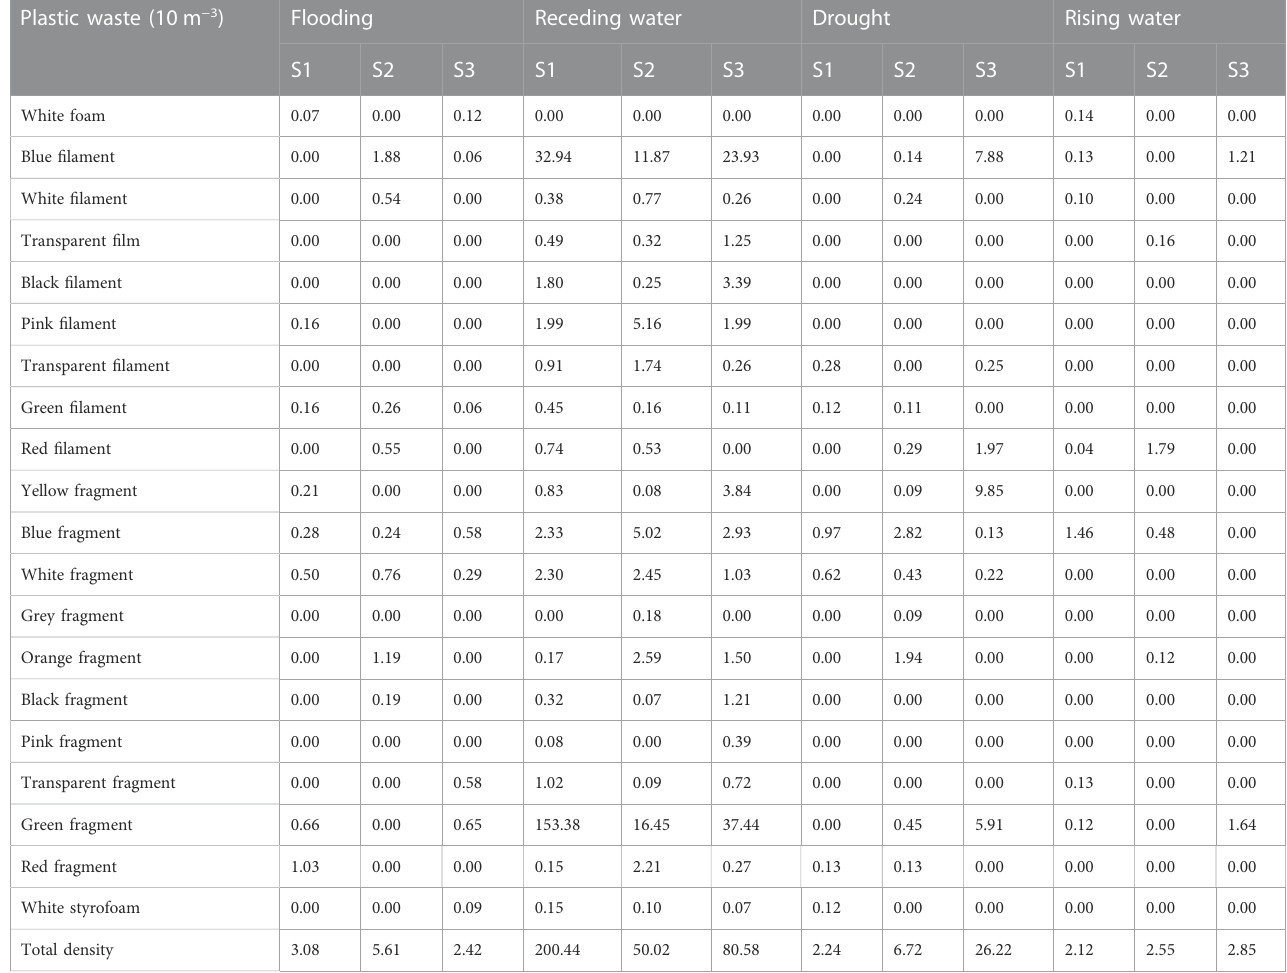
TABLE3Totaldensityper10 m − 3 andclassi fi cationofplasticwastecapturedindifferenthydrologicalphasesandsectorsoftheTapajósRiver,AmazonBasin,Brazil.S1: Sector 1; S2: Sector 2 and S3: Sector